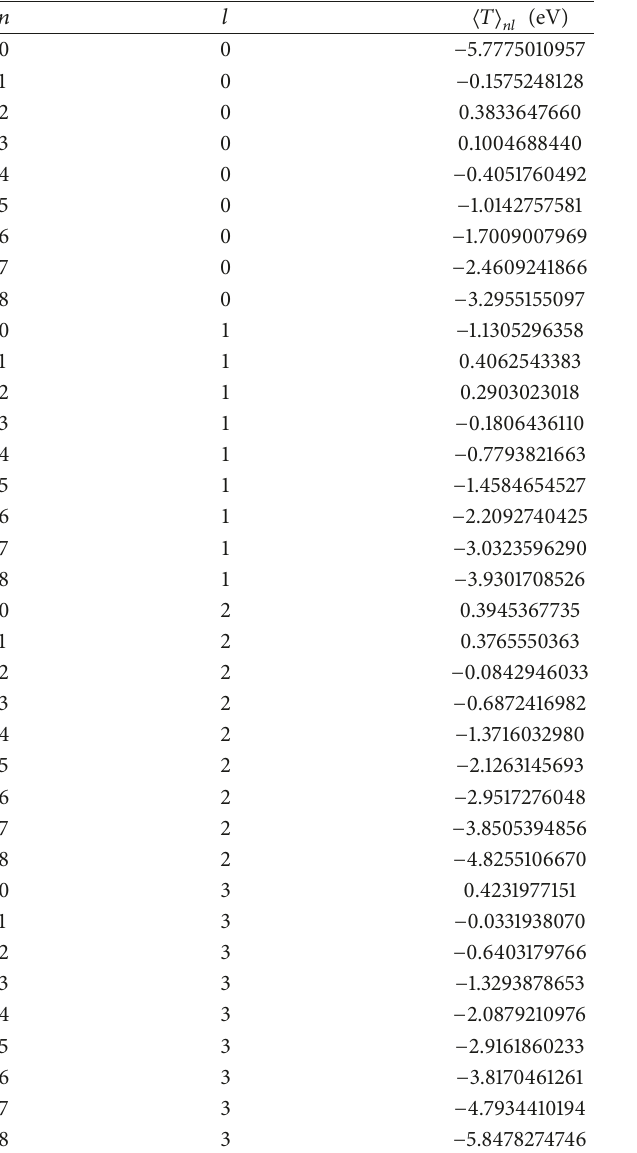
Table 10: Expectation values of ⟨𝑇⟩ for hydrogen molecule. Table 11: Expectation values of ⟨𝑇⟩ for lithium hydride